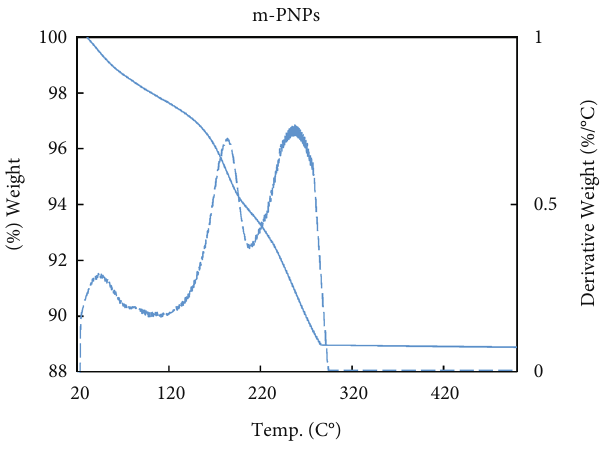
Figure 9: TGA-DTG of m-PNPs.